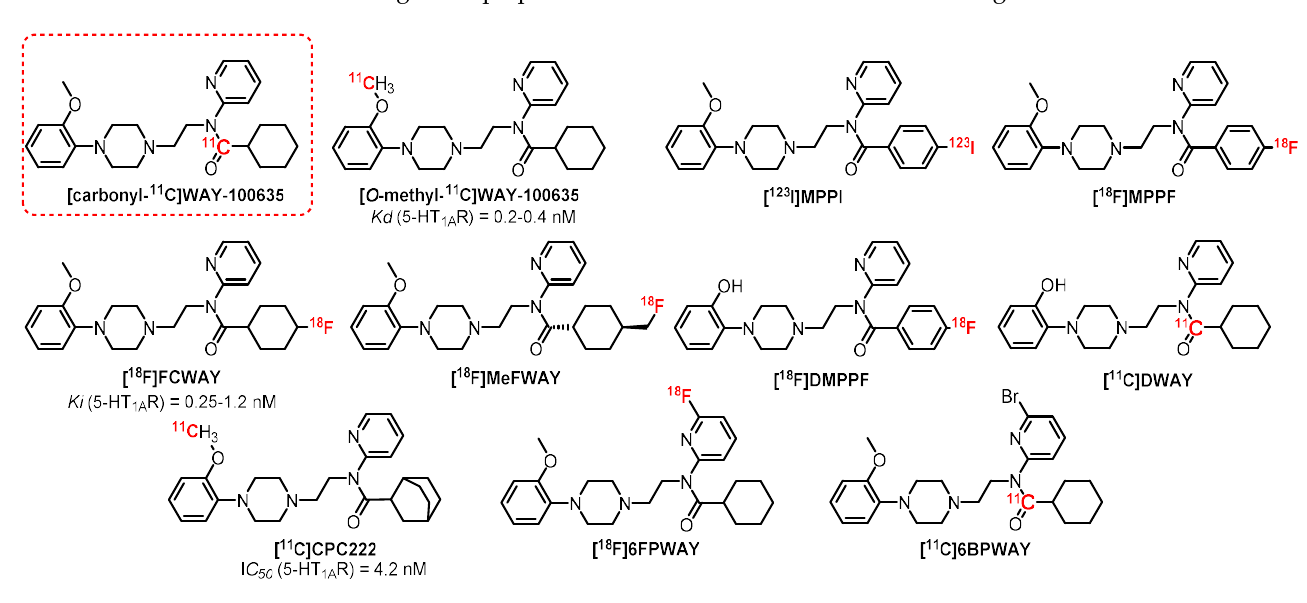
Figure 1. WAY-100365 derivatives.